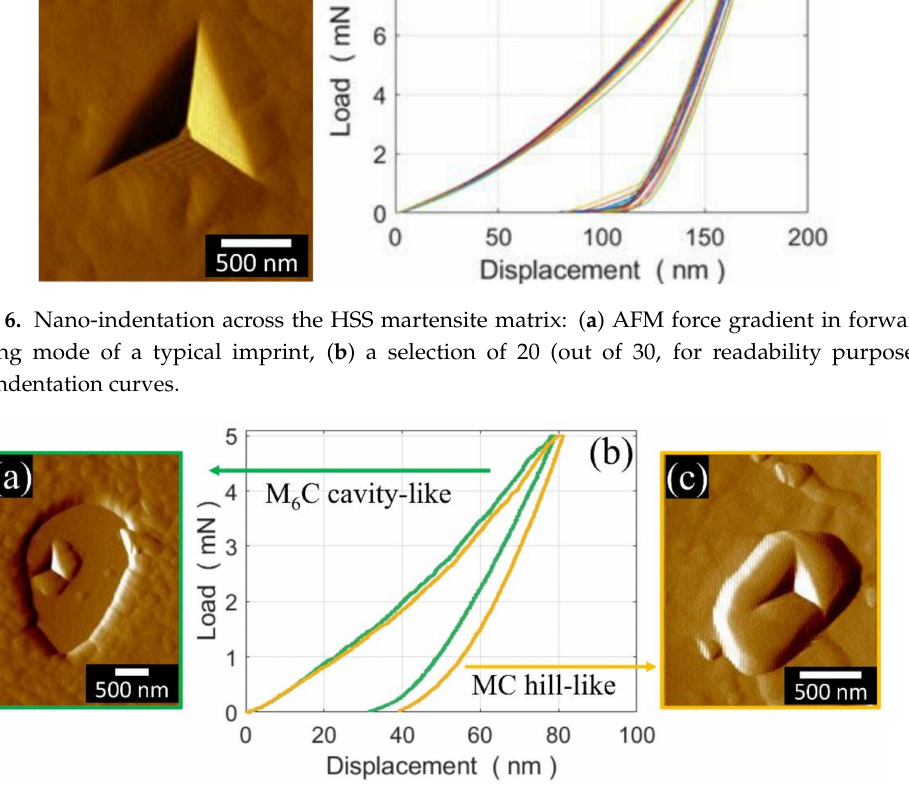
Figure 7. AFM force gradient in forward scanning mode of nano-indentation imprints over ( a ) an M 6 C cavity-like carbide and ( c ) an MC hill-like carbide, with ( b ) the relative nano-indentation